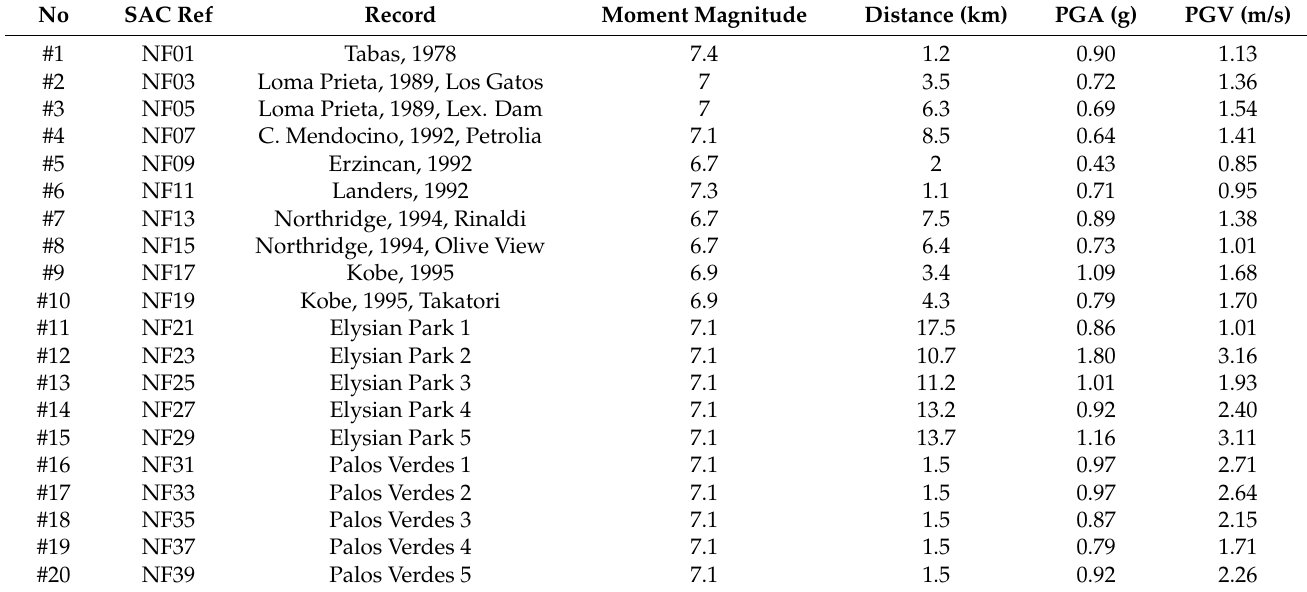
Table 1. List of near-fault